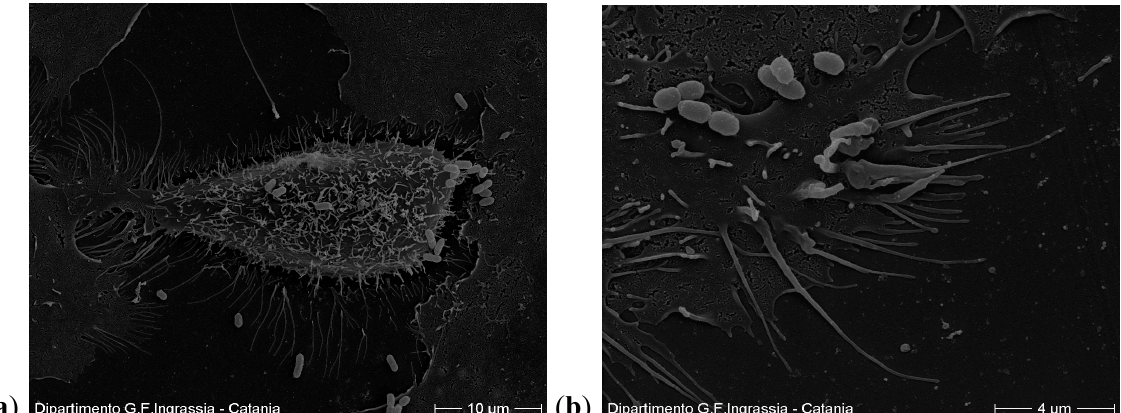
Figure 5. ( a , b ) A cell with few adhering bacteria at the concentration of 50 µg/mL. In the outer part, which is in contact with the environment, the cells have cilia, flagella and microvilli; ( c ) In the controls the cells are also integral but with a higher number of adherent